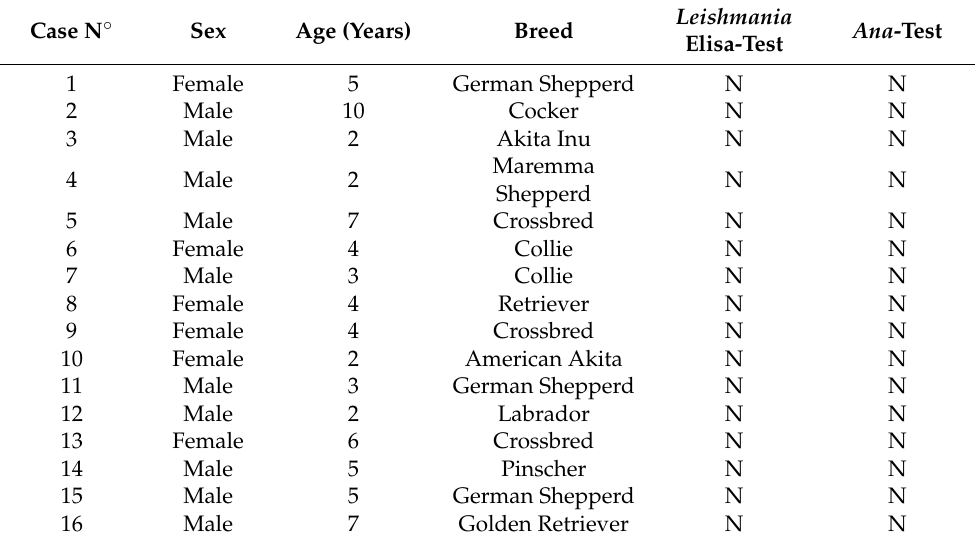
Table 1. Schematic representation of the 16 cases of discoid lupus erythematous (DLE) collected during the study (N = negative).